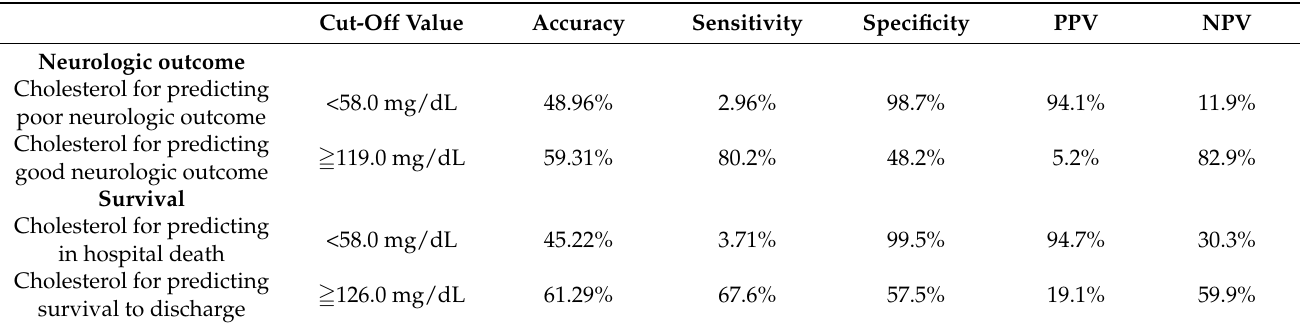
Figure 2. Receiver operator characteristic curve for prediction of neurologic outcomes using total cholesterol levels. Table 3. Cut-off and diagnostic values of cholesterol for predicting neurologic outcome and